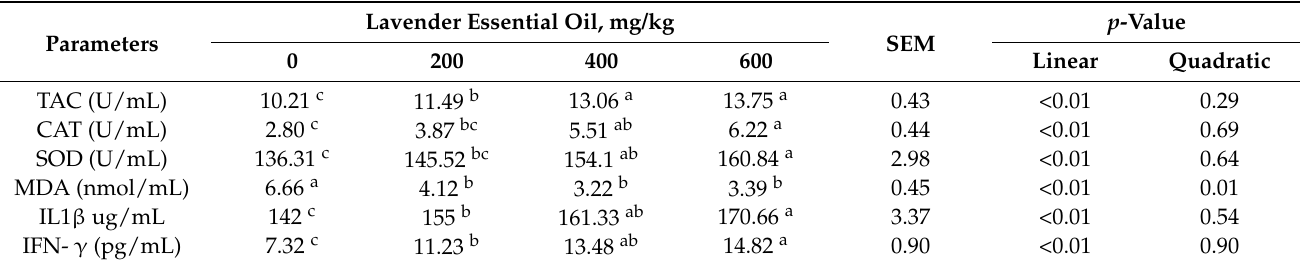
Table 7. Impact of lavender essential oil addition on broiler chickens’ serum antioxidant activity and inflammatory